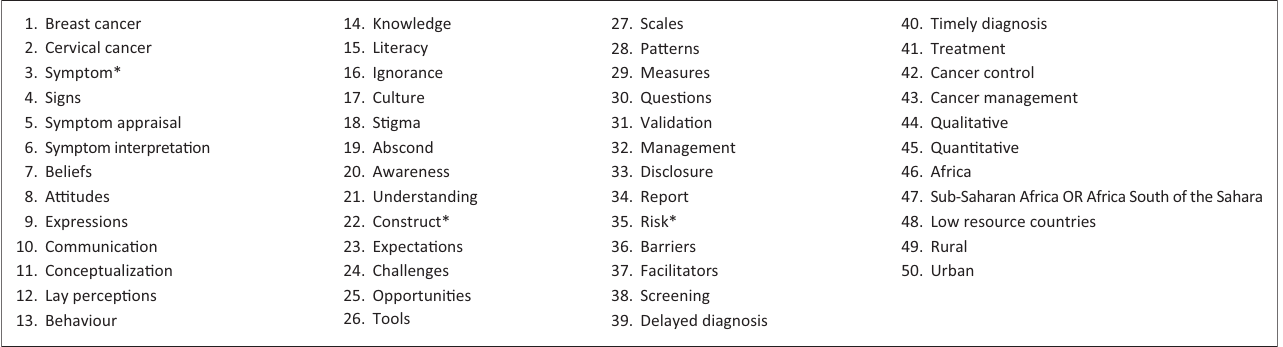
FIGURE 1-A1: List of potential search terms from existing